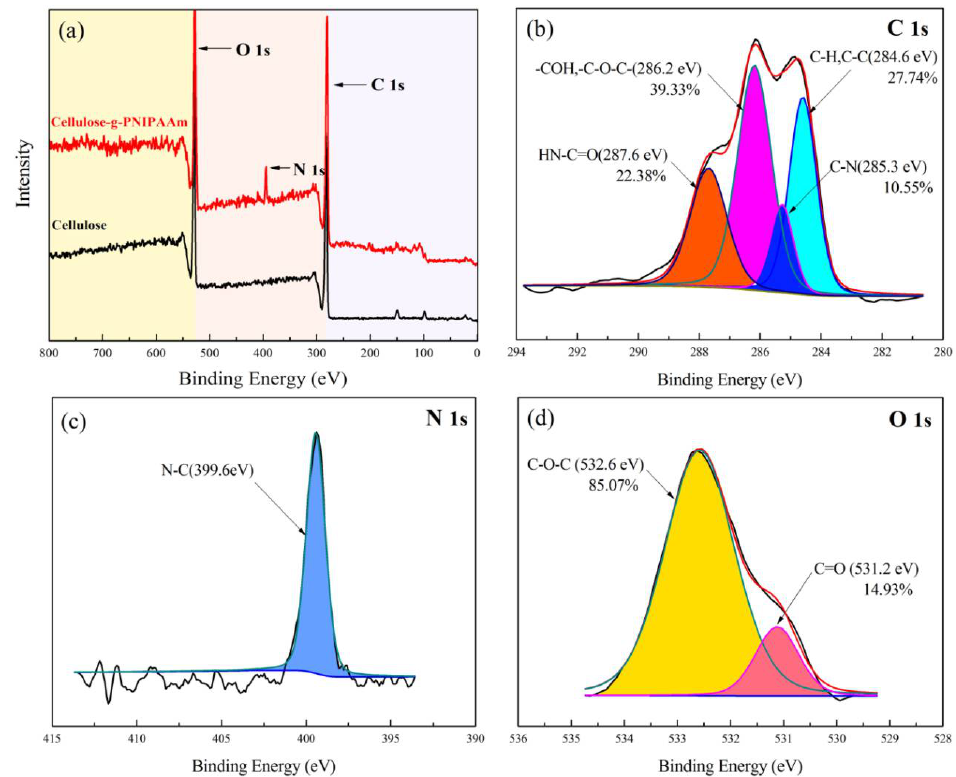
Figure 4. The wide-scan X-ray Photoelectron Spectroscopy spectra of cellulose and cellulose- g -PNIPAAm (G EA = 42.28%) ( a ); the deconvolved curves of the C 1s spectrum ( b ); the deconvolved curves of the N 1s spectrum ( c ); and the deconvolved curves of the O 1s spectrum ( d ) of cellulose- g -PNIPAAm.